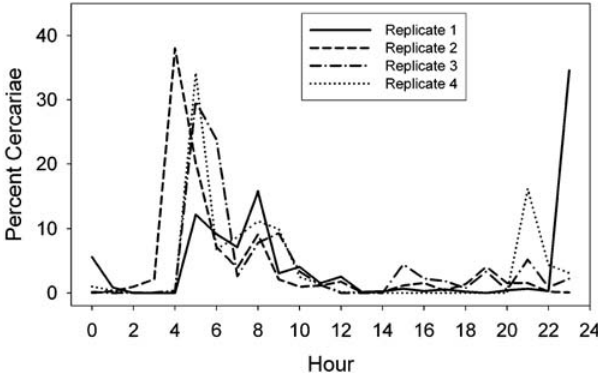
Figure 5. Four replicates of circadian emergence of cercariae from a snail infected with 3 genotypes of S. rodhaini and 1 genotype of S.mansoni . Time units are hourly units beginning with 0:00–1:00